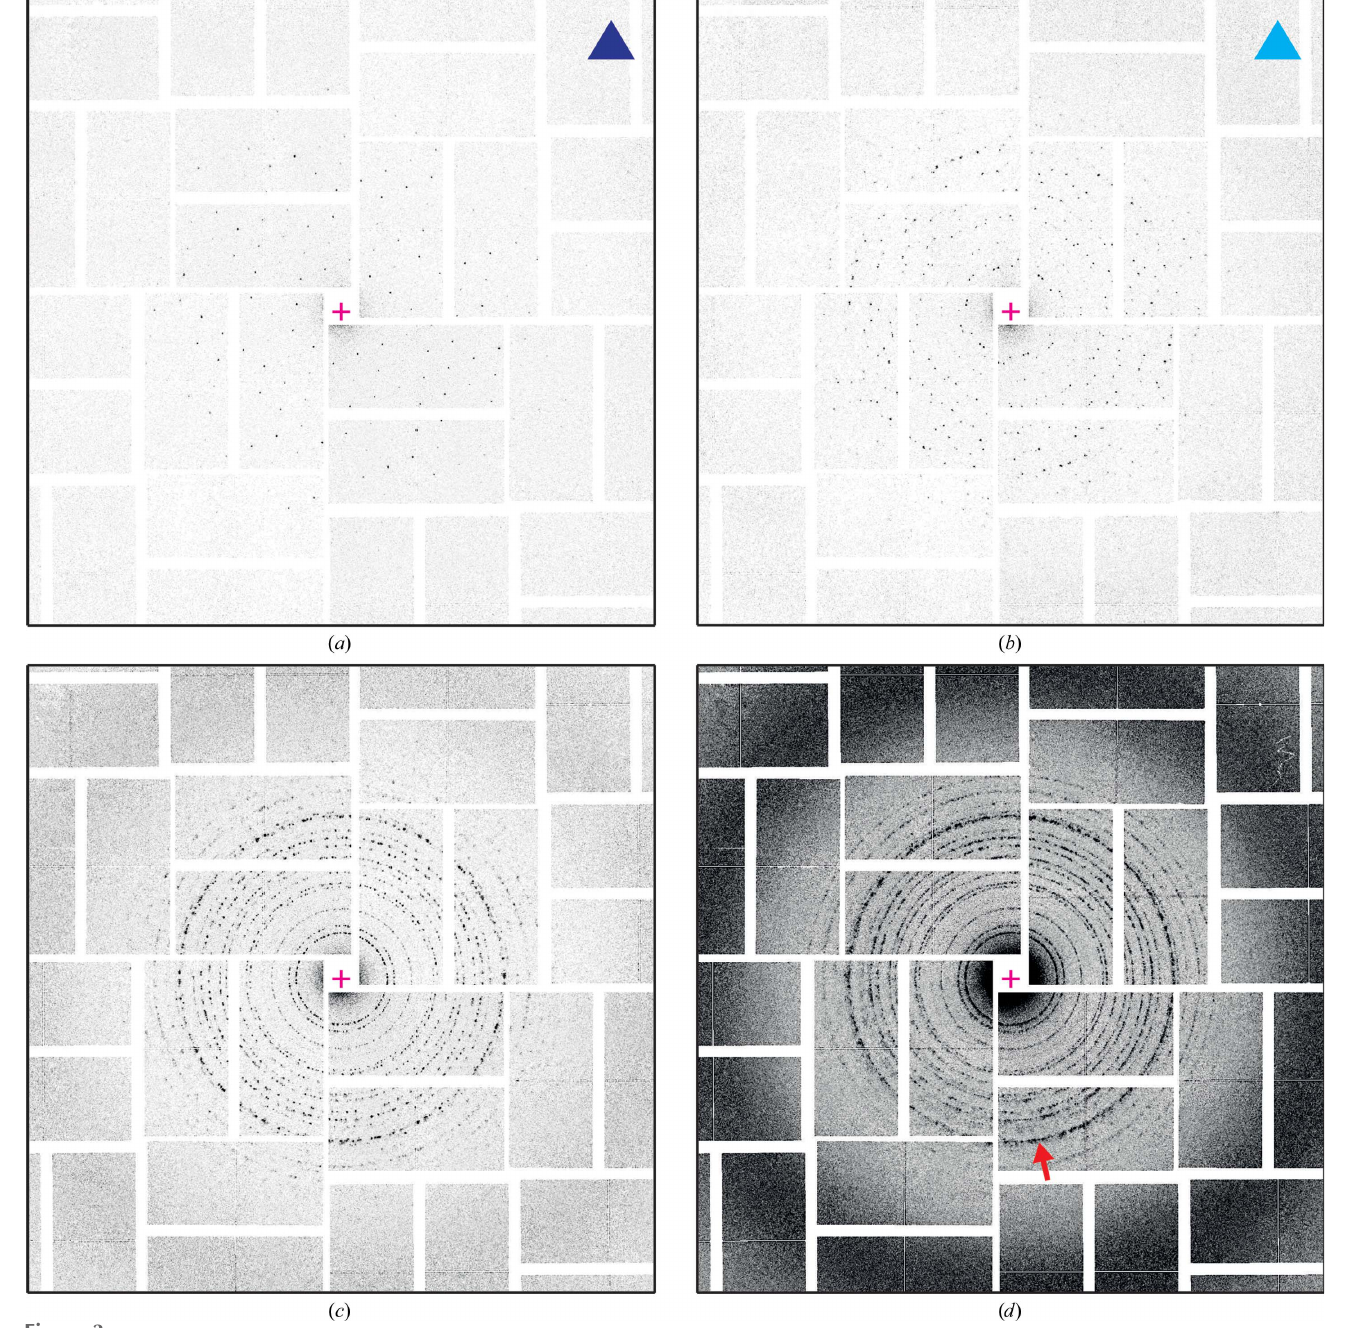
Figure 3 Diffraction images. Examples of the different types of collected diffraction images. ( a ) Single lattice. ( b ) Few lattices. ( c ) Multiple lattices. ( d ) Powder- like. The intensity scale is the same in all panels. Images of types ( a ) and ( b ) are indexable. In ( d ) the high-intensity ring labelled by the red arrow corresponds to the (3, 4) reflection and is at 8.9 A˚ in-plane resolution. The magenta cross represents the direct-beam